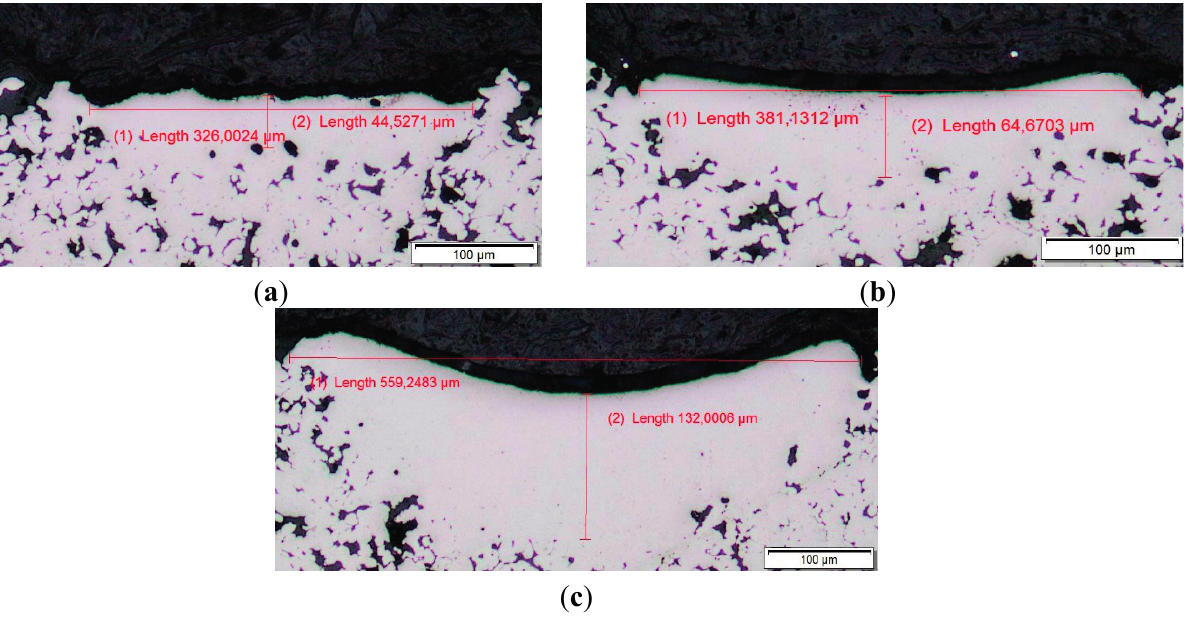
Figure 5. OM images of laser treatment surface after CS with scan velocity 10 mm/s: ( a ) P = 35 W; ( b ) P = 55 W; and ( c ) P = 90